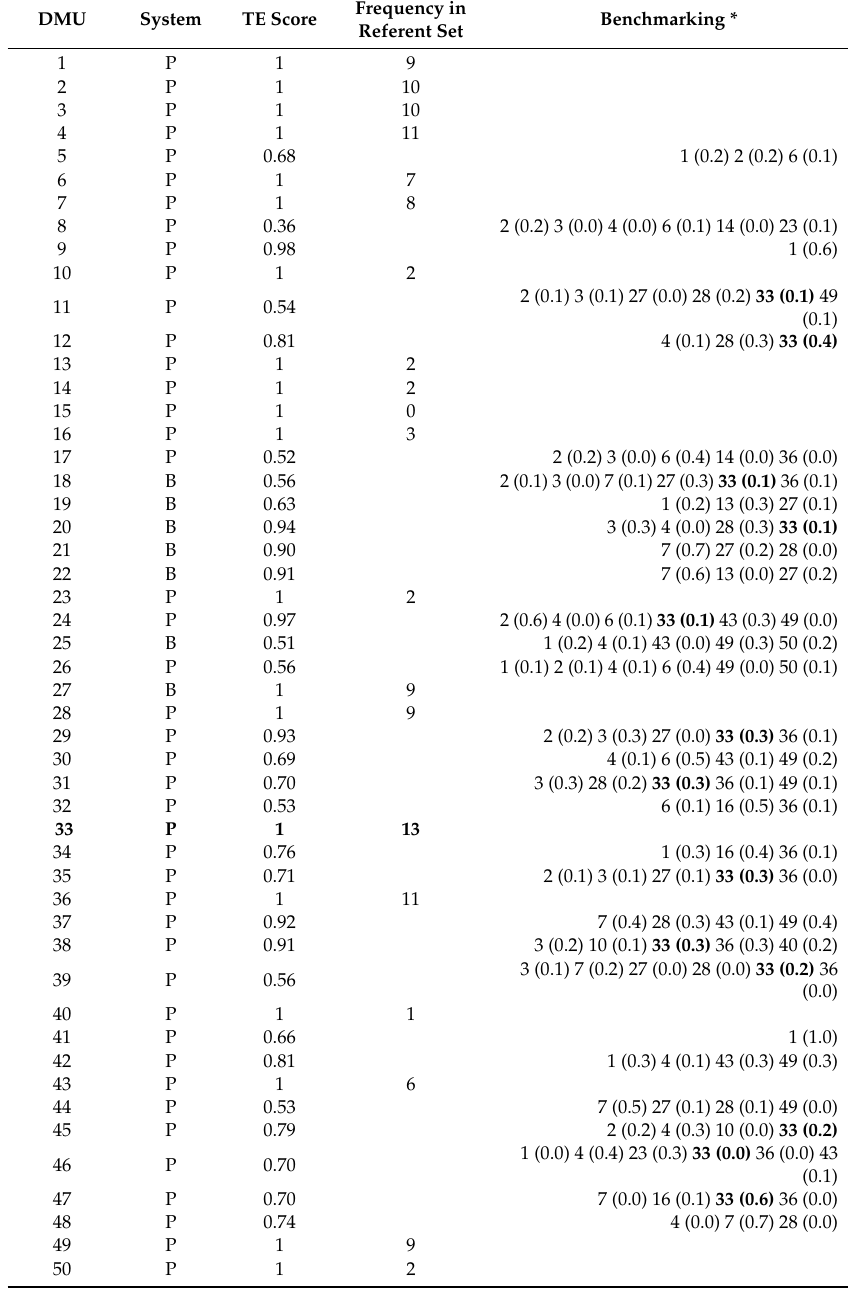
*: To simplify, the benchmarking composite units for DMU 5 are expressed as 1 (0.2) 2 (0.2) 6 (0.1), whereas 1, 2 and 6 are DMU numbers (which are e ffi cient) and values in parenthesis represent the intensity vectors of